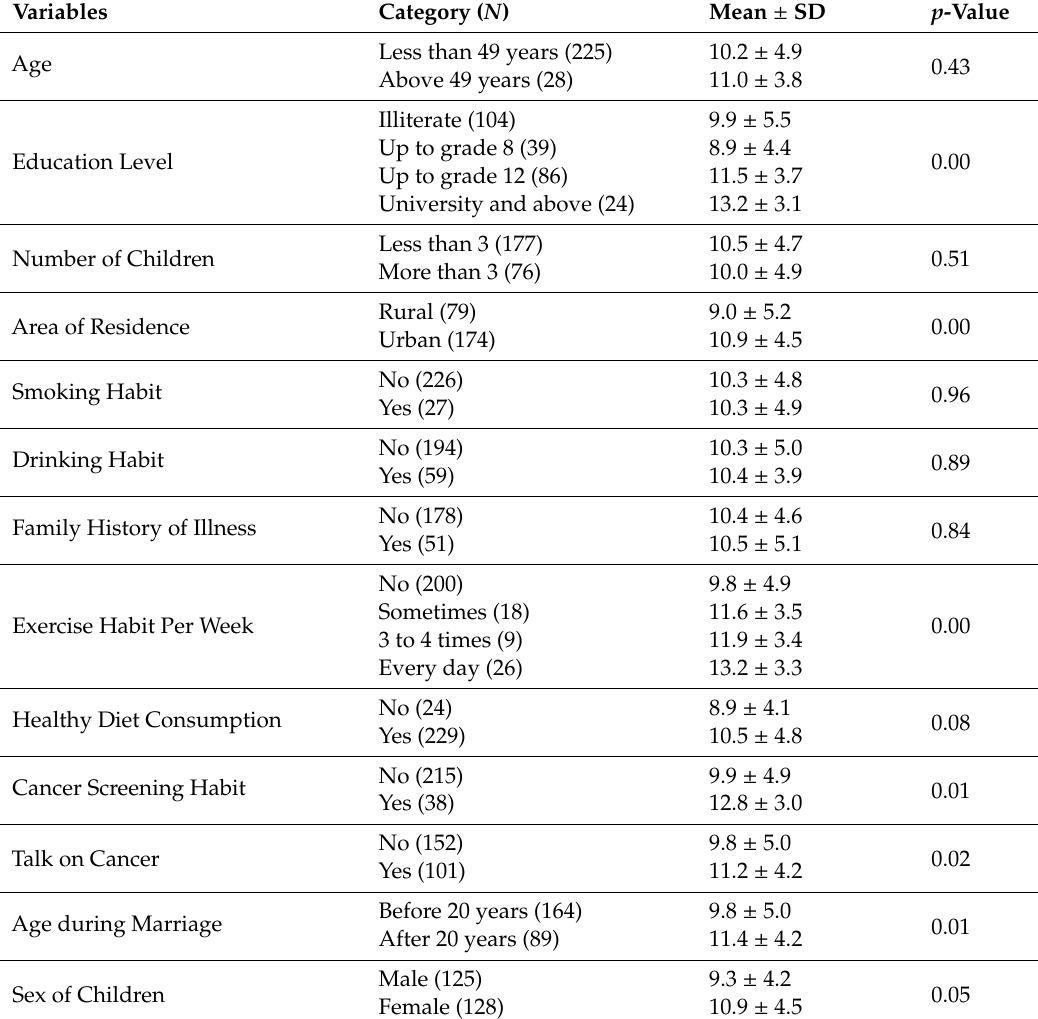
Table 3. Relationship between the demographic variables of mothers and the total cervical cancer knowledge